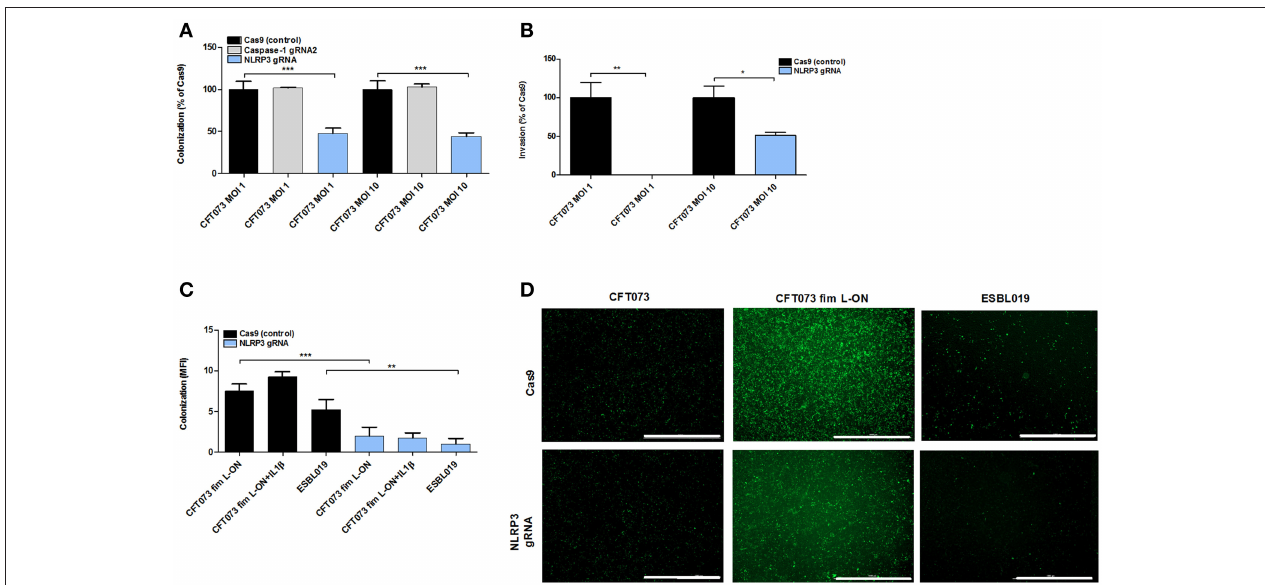
FIGURE 6 | UPEC adhesion and invasion of bladder epithelial cells. Cas9 (control cells), caspase-1 or NLRP3 deficient bladder epithelial 5637 cells were infected with CFT073 (eGFP) (A,D) , CFT073 fim L-ON (eGFP) (C,D) or ESBL019 (eGFP) (C,D) for 2h (B) or 4h (A,C,D) at MOI 1 (A,B) and MOI 10 (A–D) followed by evaluation of colonization (adhered and intracellular bacteria) and invasion (intracellular bacteria). Cells were pre-incubated with 500 pg/ml IL-1 β for 1h prior to UPEC infection (C) . Colonization is presented as percentage of Cas9 colonization (A) and as mean fluorescence intensity (MFI) (C) . Invasion was presented as percentage of Cas9 invasion (B) . Data are presented as mean ± SEM ( n = 3 independent experiments). Asterisks denote statistical significance compared to respective unstimulated control (* p < 0.05, ** p < 0.01, *** p < 0.001). Scale bar: 1,000 µ